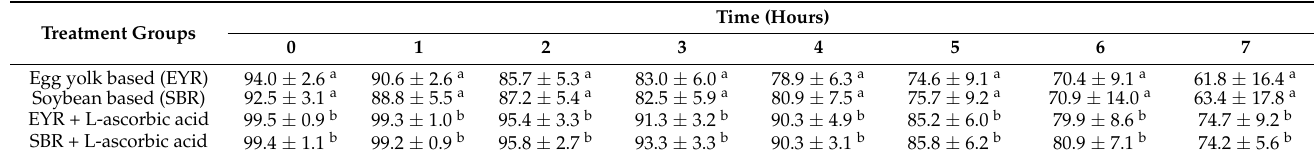
Table 3. Viability (%) of turkey spermatozoa during 7 h of storage at ambient temperature. Treatment